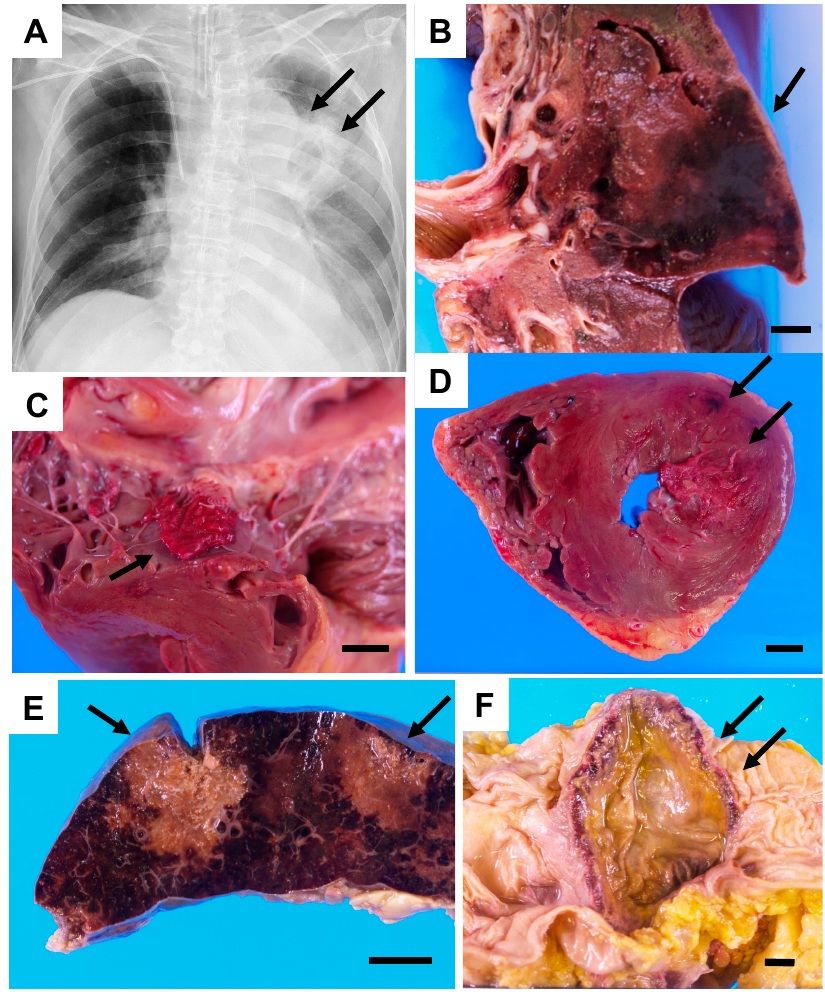
Figure 1. Chest X-ray and autopsy macroscopic findings of the autopsy case: ( A ) Chest X-ray on day 53. An infiltrative shadow with cavity formation is present in the left upper lung field (arrows). ( B ) The cut surface of the formalin-fixed upper left lung. Hemorrhagic infarction measuring 80 × 60 mm 2 in size (arrow). ( C ) Vegetation of the mitral valve (arrow). ( D ) The horizontal cut surface of the heart. Ischemic change with hemorrhage in the posterior–lateral wall of the left ventricle (arrows). ( E ) Cut surface of the formalin-fixed spleen. Necrotic foci are observed (arrows). ( F ) Formalin-fixed colon. Tumor-like ulceration up to 100 mm in size is present in the transverse colon (arrows). Each scale bar in the figure is 10